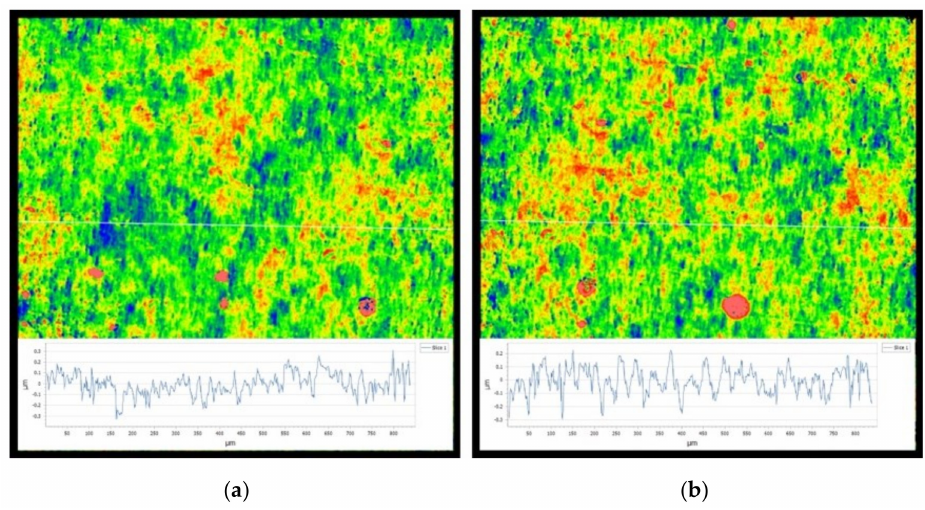
Figure 21. The surface topography of the PVDF thin film before the test: ( a ) 0 V and ( b ) 3 V. Figure 22 shows the wear volume and specific wear rate versus voltage curves with F n = 50 N, D = ± 20 µ m and ƒ = 15 Hz. The wear volume and specific wear rate show the same trend. With the increase in voltage, both wear volume and specific wear rate first increase and then decrease and reach the minimum value at V c = 3 V, where the wear